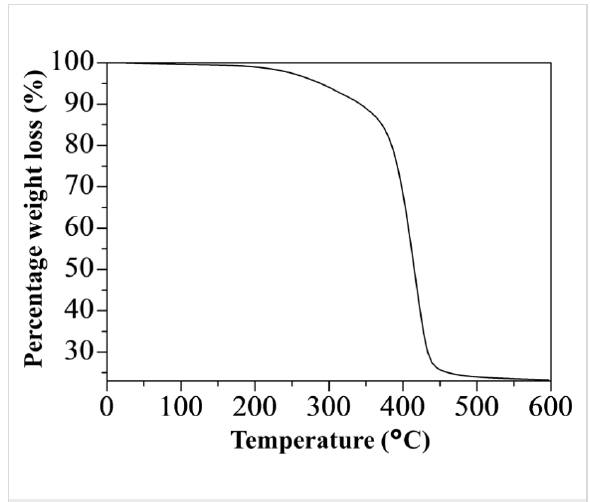
Figure 2: TGA thermogram of [Au 3 Pz 3 ] C10TEG